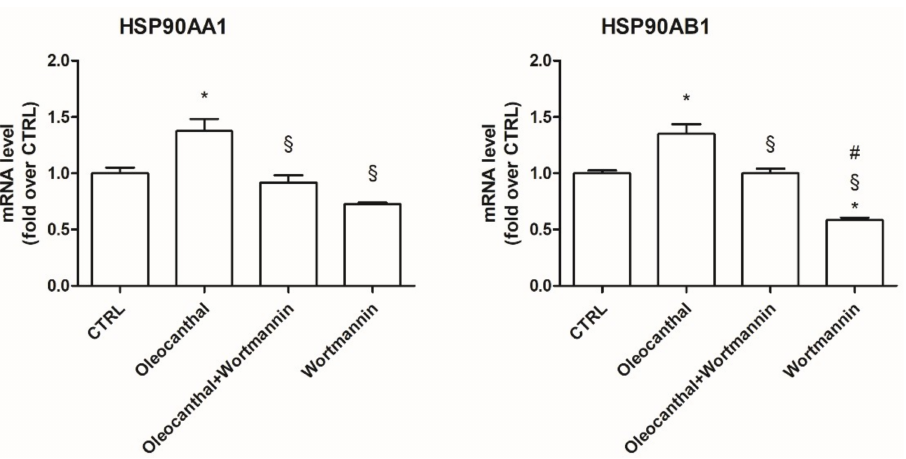
Figure 10. Akt-specific inhibitor wortmannin prevents oleocanthal-induced HSP90s. Differentiated SH-SY5Y were treated with 100 nM wortmannin 1 h before exposure to 10 µ M oleocanthal for 24 h. Total RNA was isolated, and the mRNA level of target genes was quantified using RT-PCR normalized to 18S rRNA reference gene as reported in Materials and Methods. Triplicate reactions were performed for each experiment. Each bar represents the mean ± SEM of three independent experiments. Data were analyzed by one-way ANOVA followed by Bonferroni’s test. * p < 0.05 with respect to CTRL;